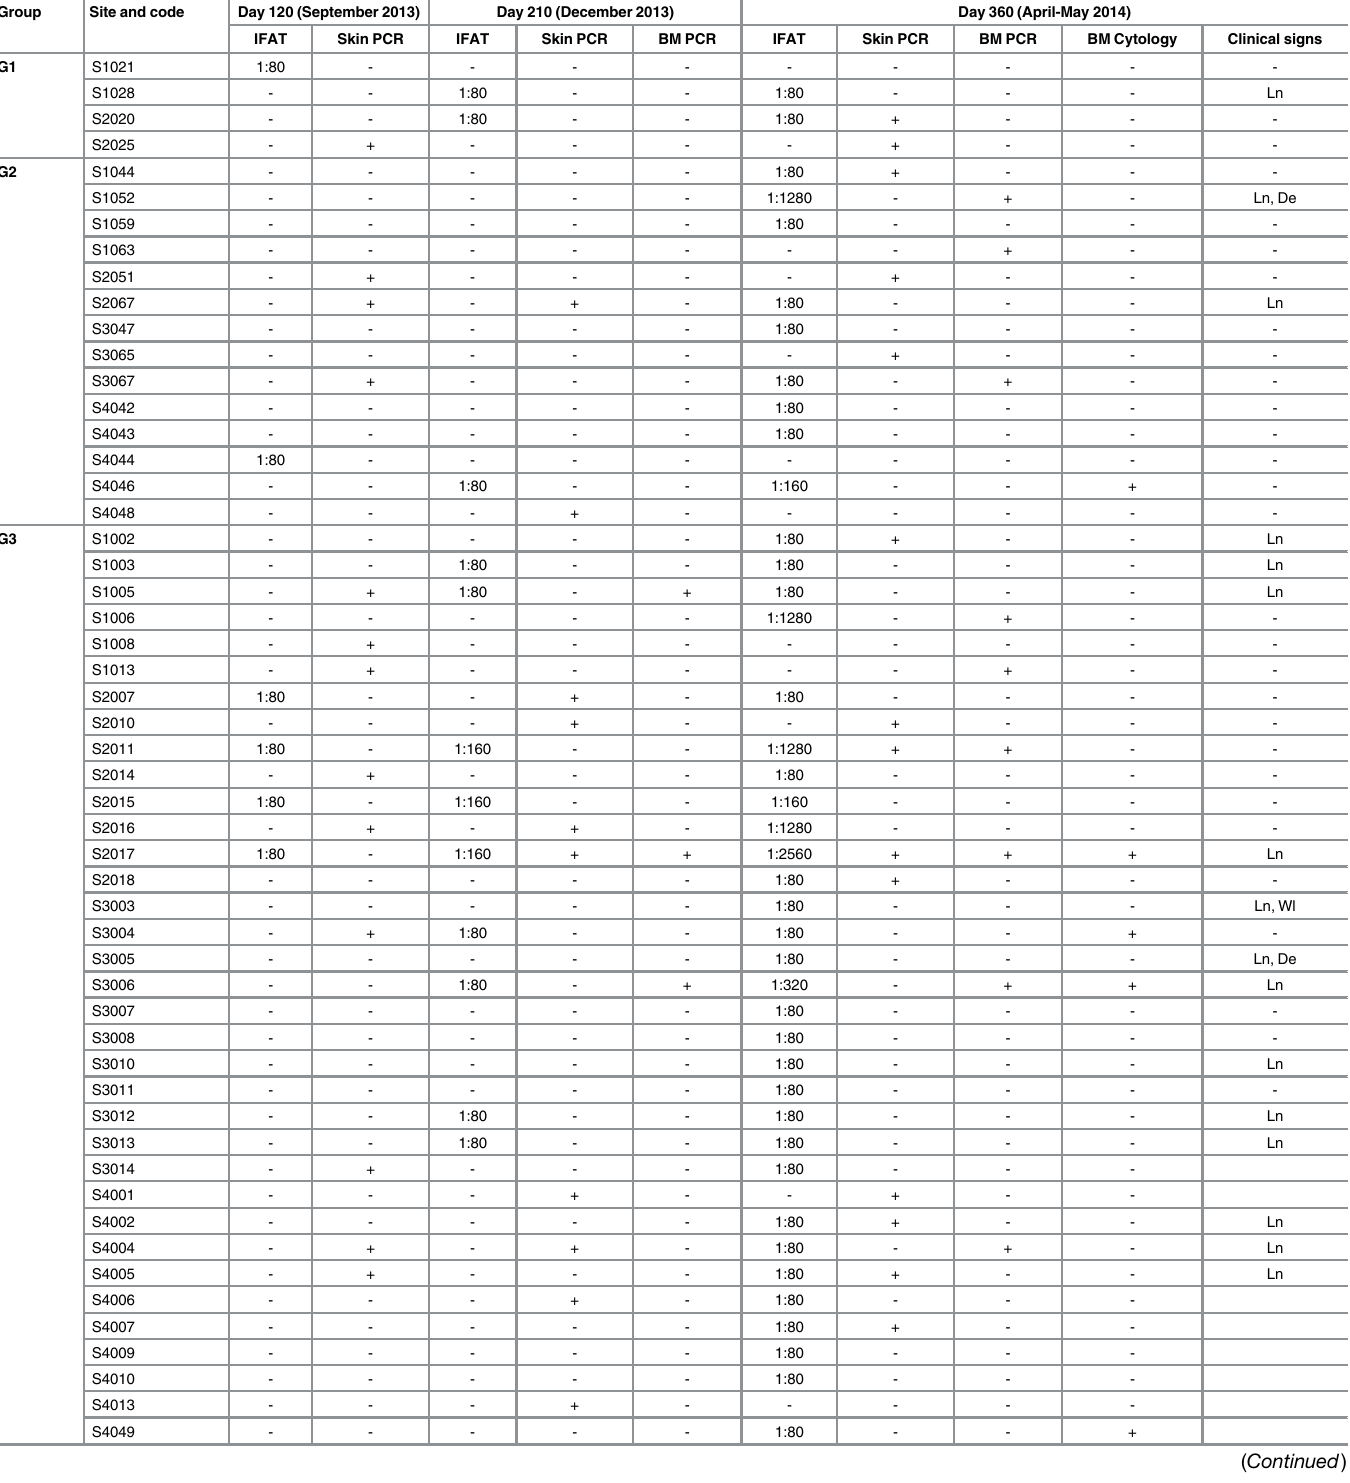
Table 2. Serological, molecular and cytology results only of dogs positive for Leishmania infantum at IFAT, PCR on skin or bone marrow (BM) or BM cytology at any time point during the study. Group Siteandcode